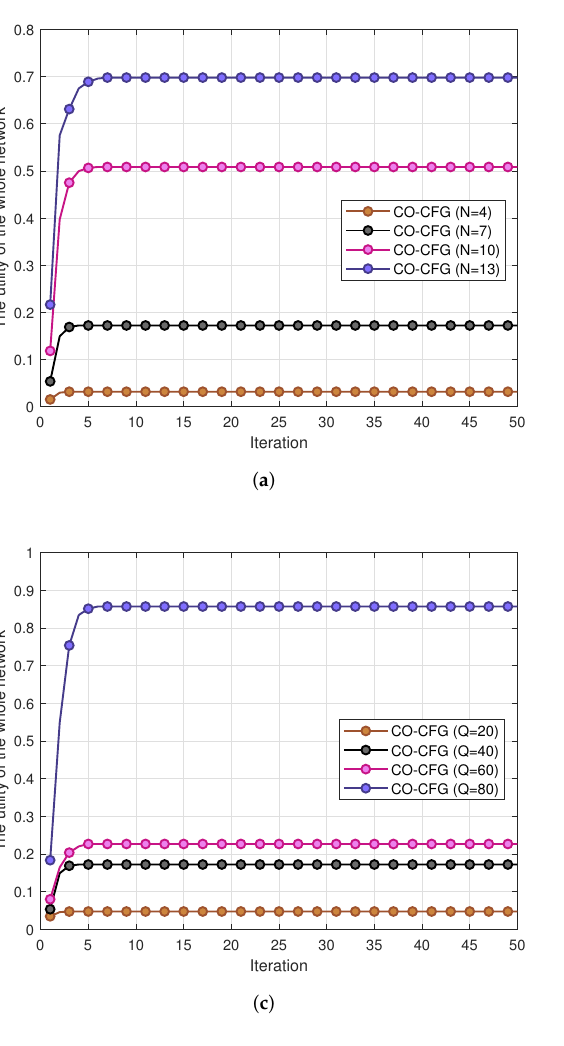
Figure 7. The convergence performance of the proposed CO-CFG algorithm. ( a ) The convergence of the CO-CFG algorithm under different numbers of UAVs. ( b ) The convergence of the CO-CFG algorithm under different numbers of users. ( c ) The convergence of the CO-CFG algorithm under various UAV cache capacities. ( d ) The convergence of the CO-CFG algorithm, PO-CFG algorithm and SO-CFG